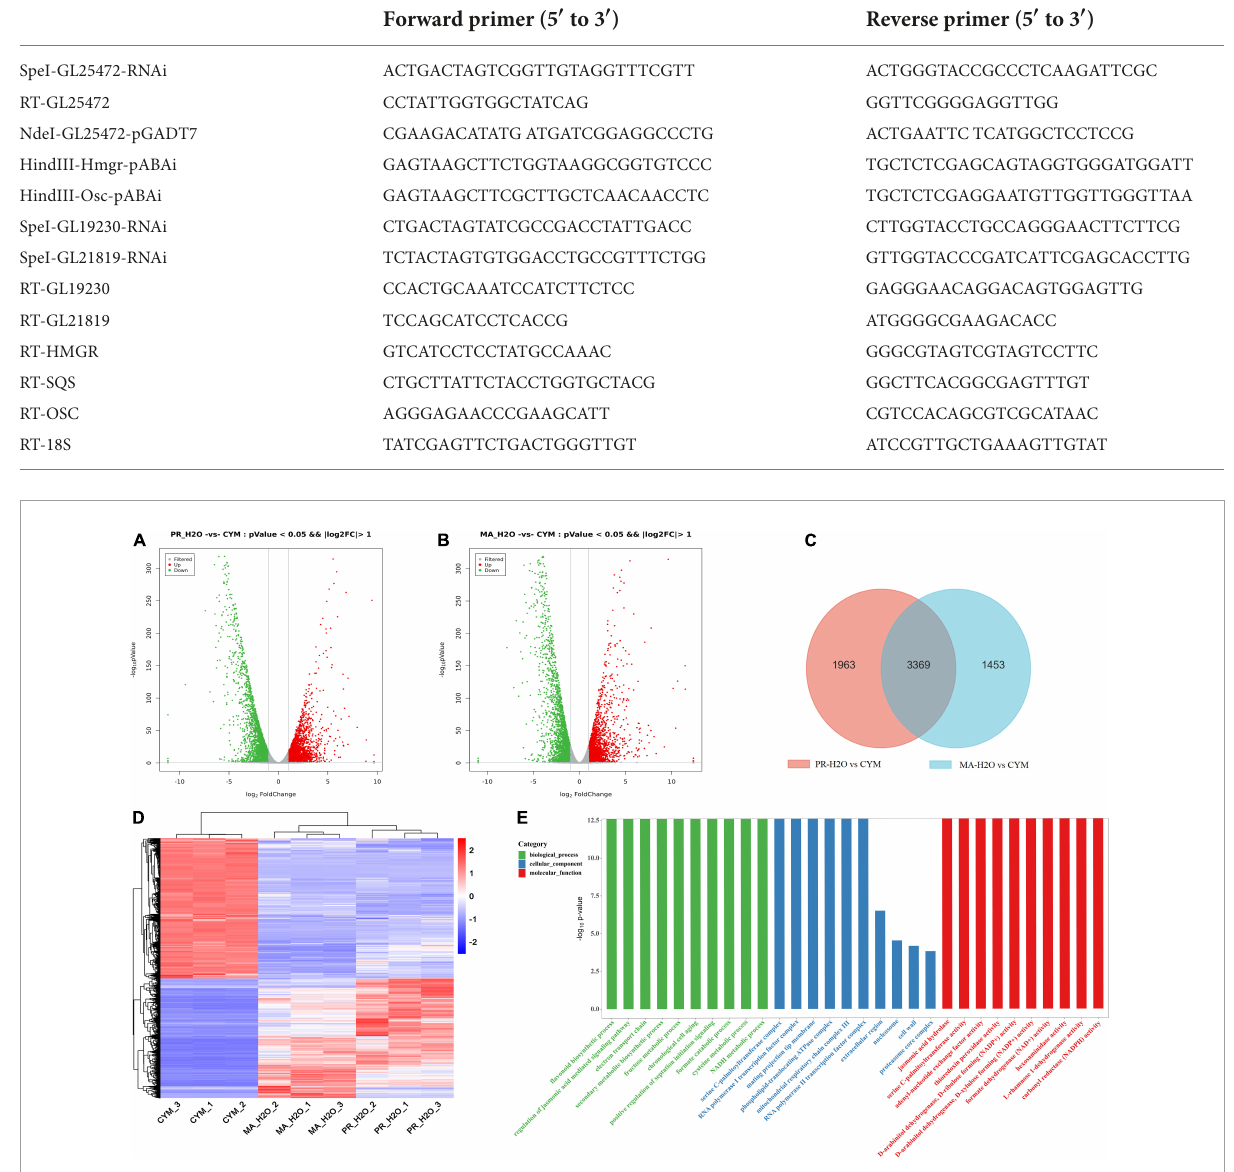
FIGURE1 The transcriptome analysis in different developmental stages. Panels (A,B) are the DEGs in PR-H 2 O vs. CYM and MA-H 2 O vs. CYM, respectively. Panel (C) is Venn diagram of DEGs between (PR-H 2 O vs. CYM) and (MA-H 2 O vs. CYM). Panels (D,E) are the heat map and GO enrichment analysis of common genes. CYM, mycelia; PR-H 2 O, primordia; MA-H 2 O, fruiting body. There are three replicates in each sample of